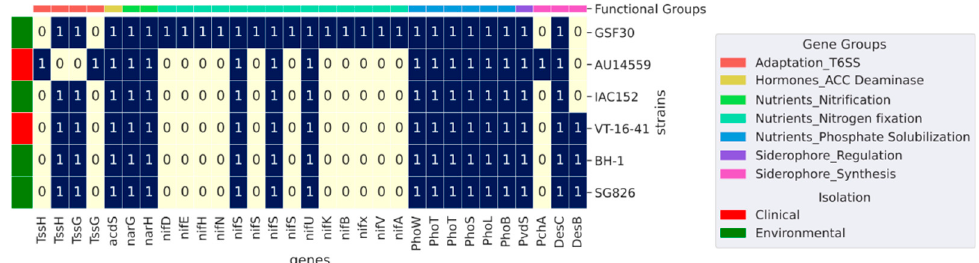
Figure 4. Plant growth-promoting factors identified through comparison via BLASTP between representatives of the clusters generated by Panaroo and the plant growth-promoting proteins listed by Kuramae et al. (2020) [18]. Only alignments that presented at least 80% coverage and 50% identity with the respective reference proteins were considered. Lines are colored according to isolation source, environment, and clinic, and the columns are colored according to the functional group to which each gene